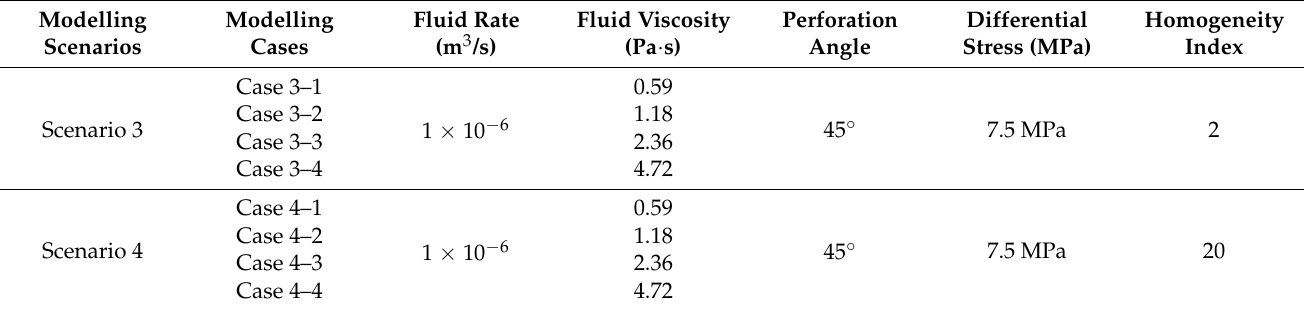
Table 7. Modelling scenarios to study the effect of fluid viscosity on HF re-orientation in heteroge- neous